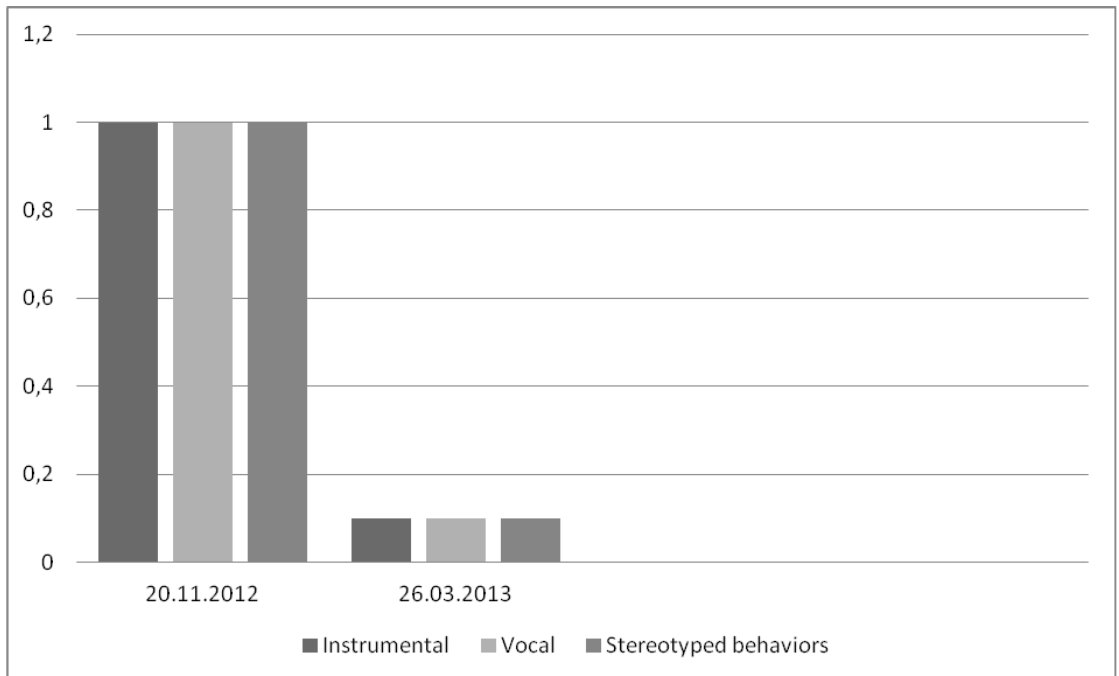
Fig. 2. Evoked responses (a (cid:222) ve-year-old boy)